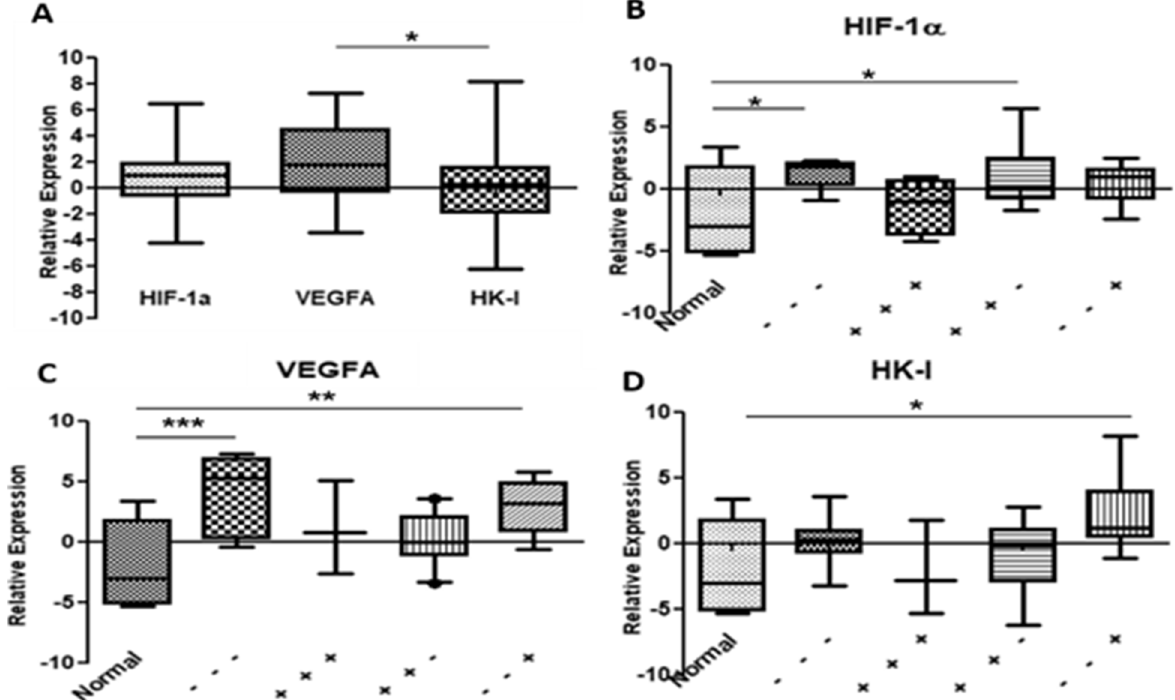
Fig. 1 mRNA expression of HIF-1α, VEGFA & HK-I in breast cancer and its subtypes. A Relative mRNA expression profile of HIF-1α, VEGFA & HK-I in breast cancer tissues. B HIF-1α mRNA expression in breast cancer subtypes correlated with normal tissue. C VEGFA mRNA expression in breast cancer subtypes correlated with normal tissues. D HK-I mRNA expression in breast cancer subtypes correlated with normal tissues. - -- represents TNBC. represents Estrogen, Progesterone & Her2 positive. - represents Estrogen, Progesterone positive & Her2 negative. - - + + + + + Estrogen, Progesterone negative & Her2